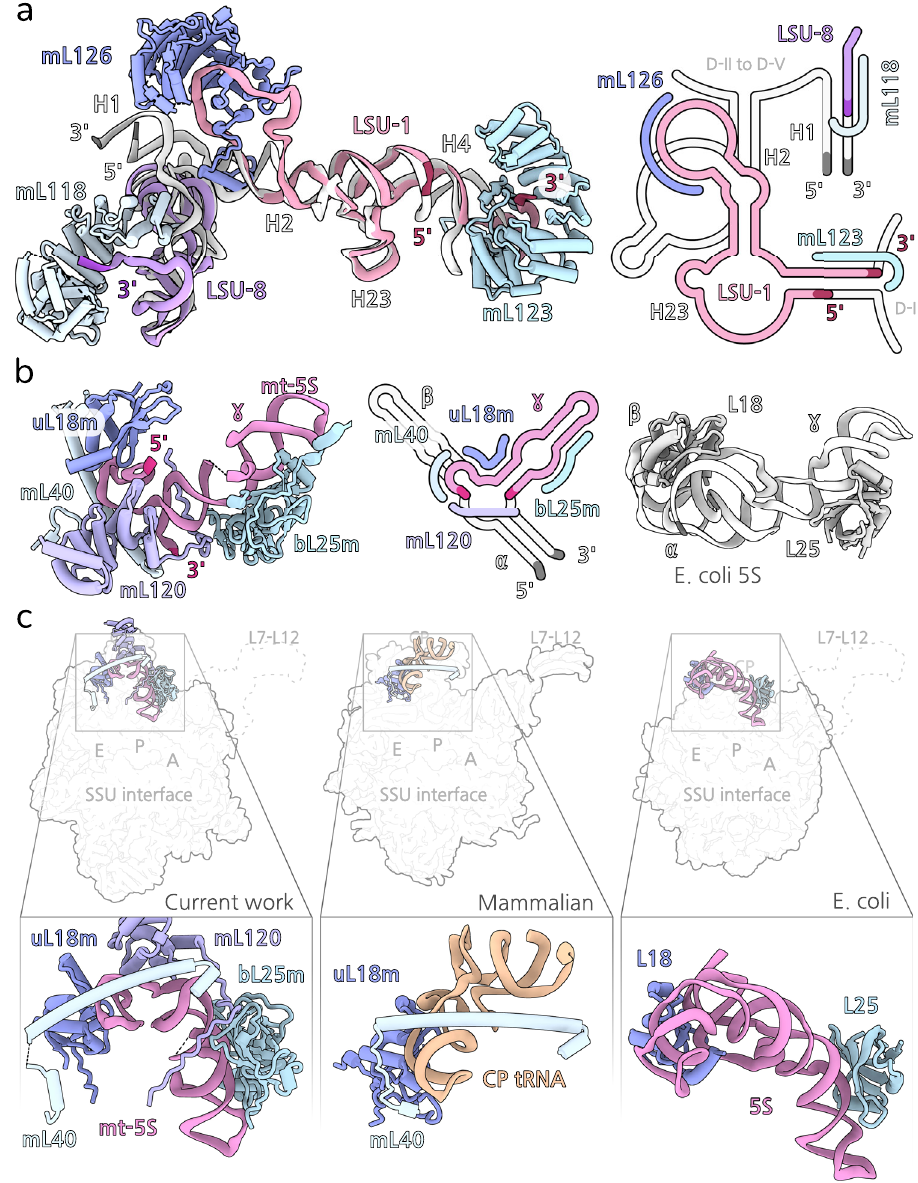
Fig.5|ReducedLSU-1andmt-5SrRNAs.a LSU-1fragment(pink)isboundbythree HEAT protein superimposed with E. coli rRNA (white, PDBID: 7K00). A secondary structurediagramisshownontheright,andproteinbindingregionsareindicated. b The mt-5S rRNA compared with E. coli 5S and their bound proteins. A secondary structure diagram is shown in the middle, and protein binding regions are